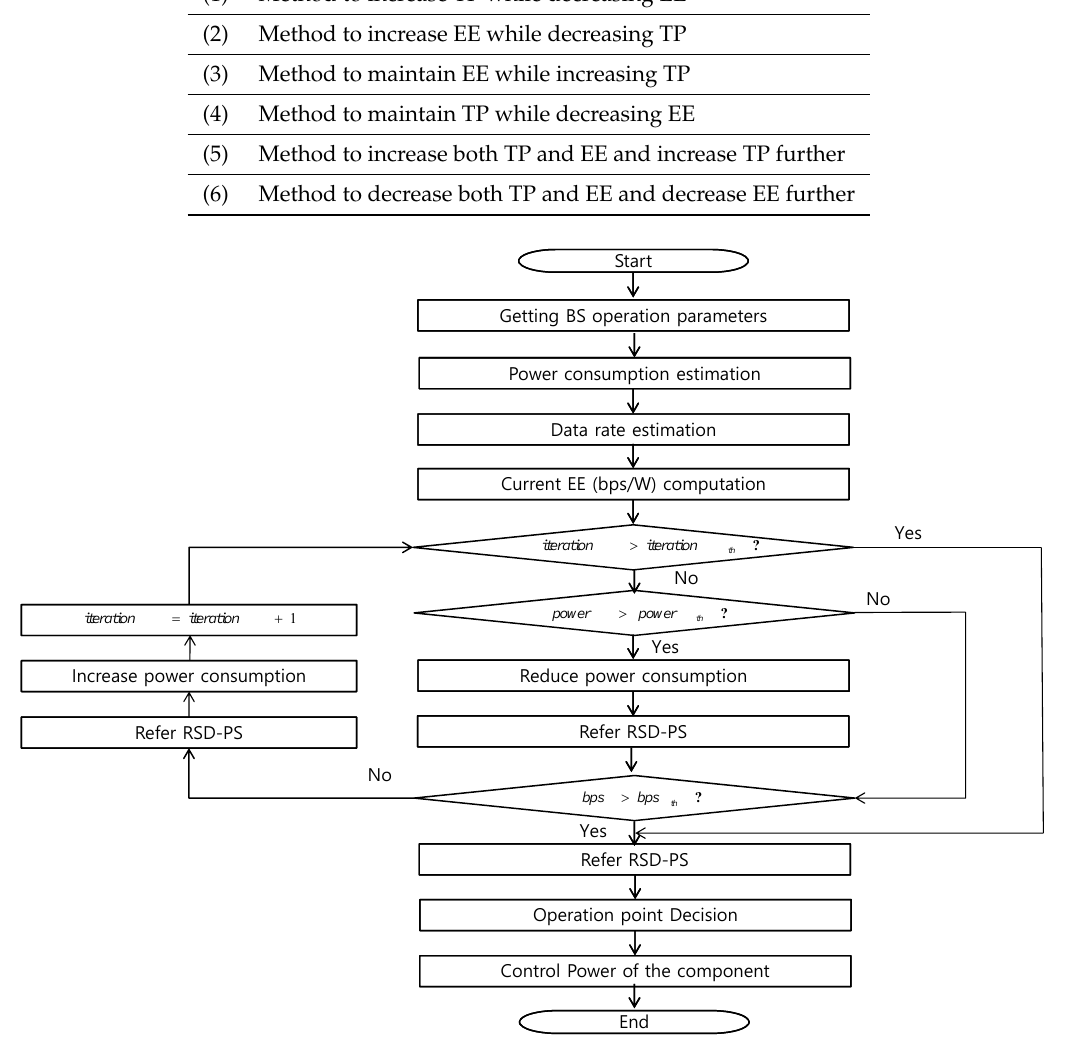
Figure 6. Example of the systematic operation of the proposed